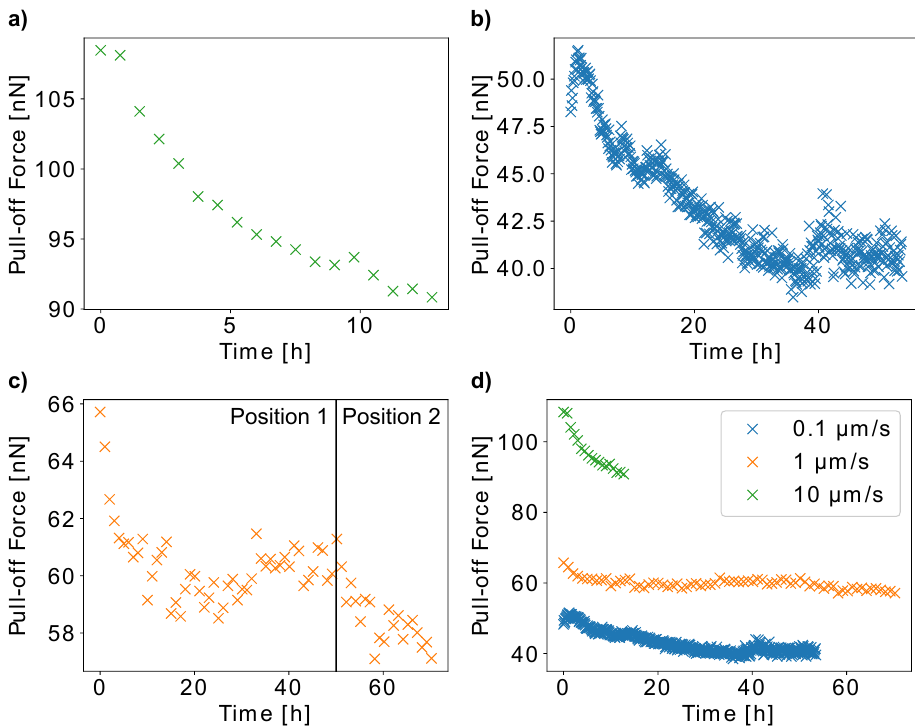
Figure 5. The pull-off forces of three single Hypochaeris radicata pollen grains from glass substrates measured repeatedly for 12 h ( a ) or more than 50 h ( b , c ) at different pull-off rates. ( d ) The pull-off forces plotted over time for all three pollen. The adhesiveness is decreasing over time for each pollen grain. The pollen measured with a cantilever speed of 10 µm/s has the highest pull-off forces, and the quickest decrease in